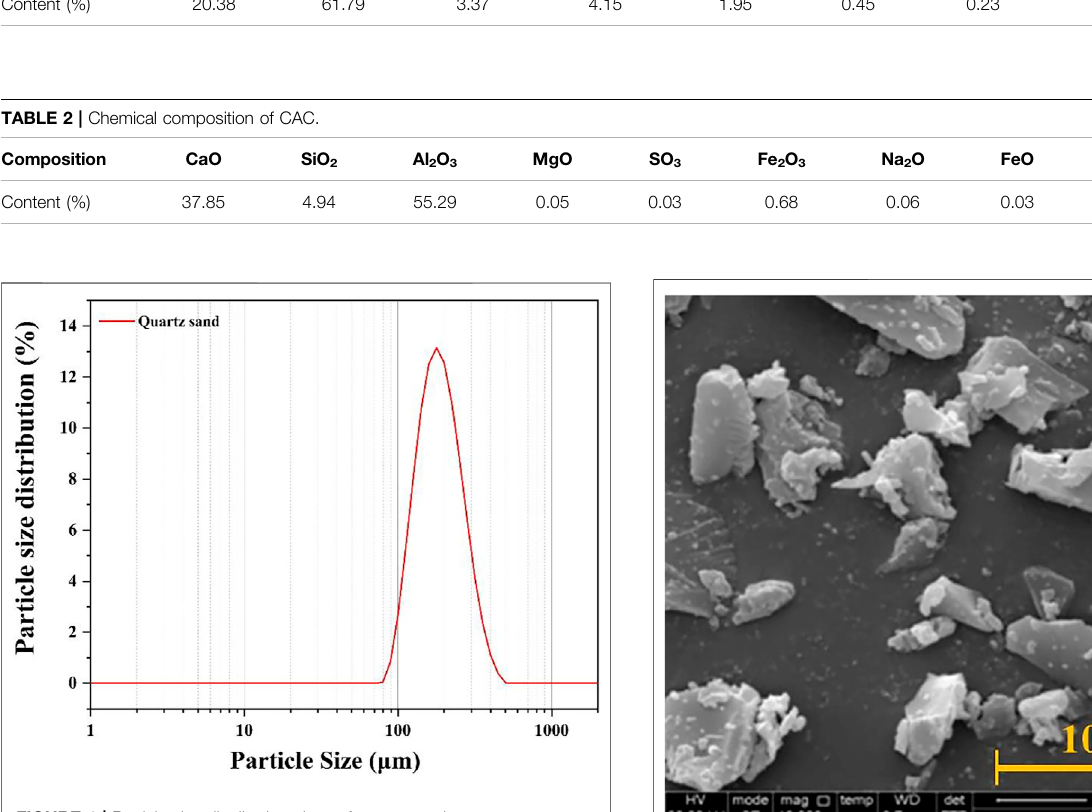
FIGURE 1 | Particle size distribution chart of quartz sand.